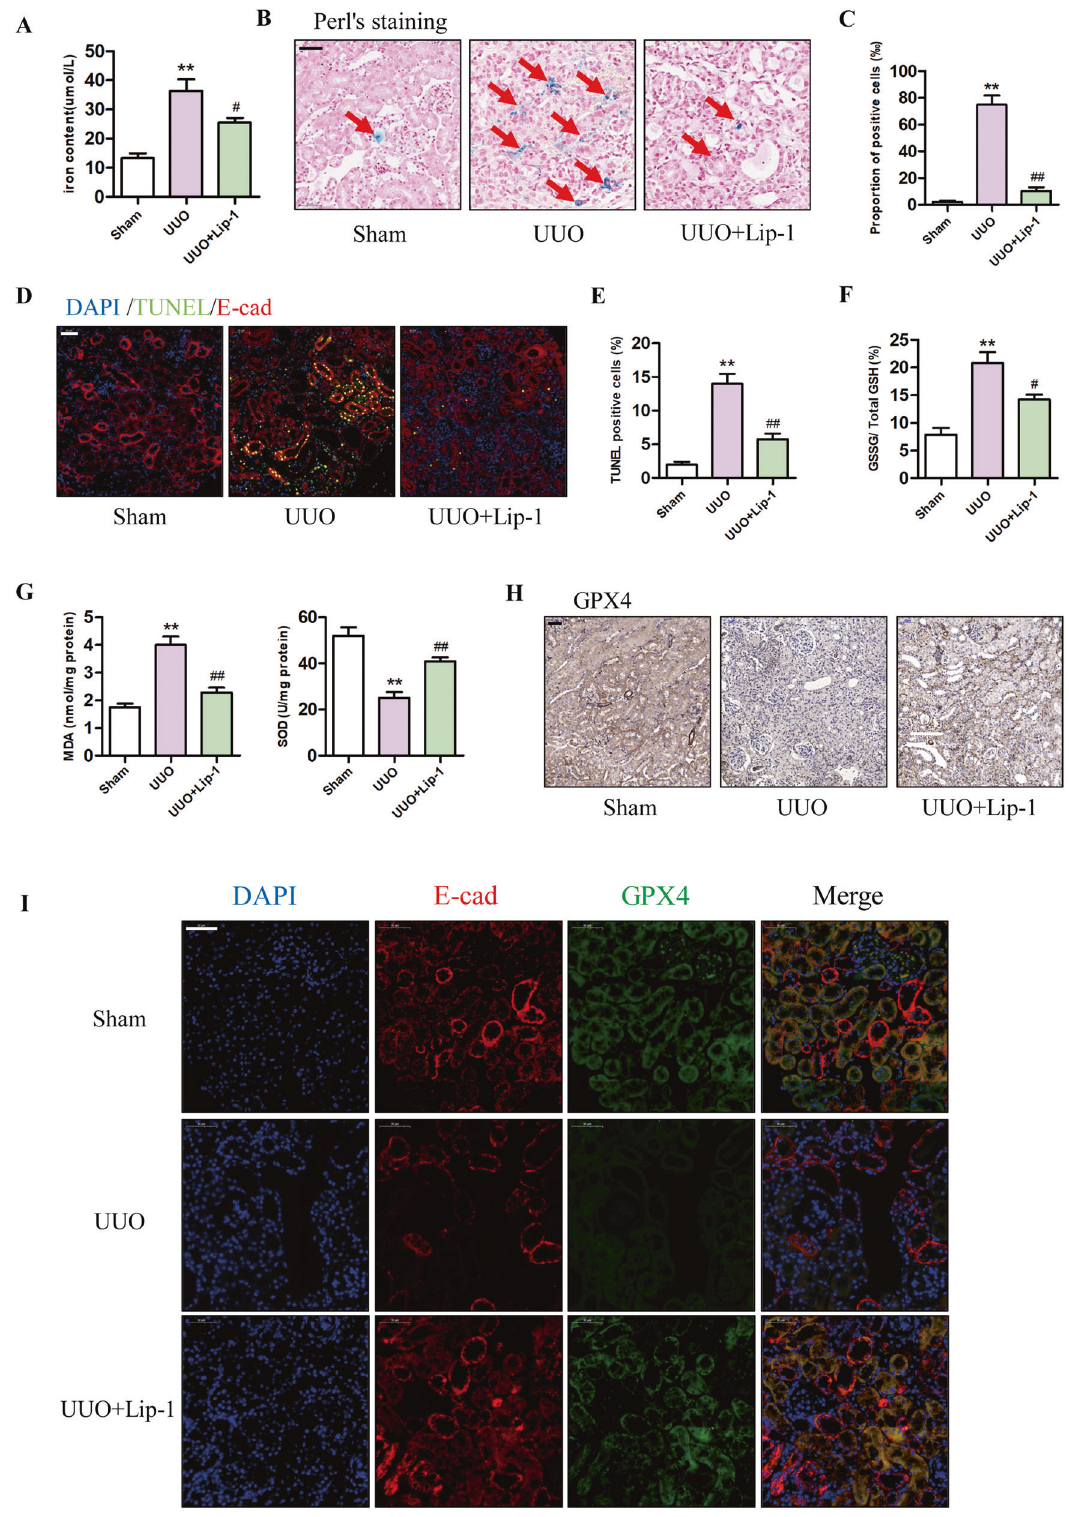
Fig. 1 Effects of Liproxstatin-1 on renal iron deposition, cell death, lipid peroxidation, and GPX4 expression in the UUO model. A Iron concentrations in the kidney tissue lysates ( n = 4, ** P < 0.01 vs Sham group; # P < 0.05 vs UUO group). B Perl ’ s staining of kidney tissues (bar = 50 μ m). C Proportion of Perl ’ s staining positive cells ( n = 4, ** P < 0.01 vs Sham group; ## P < 0.01 vs UUO group). D E-cad and TUNEL co-staining in the kidney tissues, DAPI (blue), E-cad (red), and TUNEL (green) (bar = 50 μ m). e Quanti fi cation of TUNEL-positive cells in the kidney tissues ( n = 4, ** P < 0.01 vs Sham group; ## P < 0.01 vs UUO group). F GSSG/total GSH ratio in kidney tissues ( n = 4, ** P < 0.01 vs Sham group; # P < 0.05 vs UUO group). G MDA and SOD levels in the kidney tissues ( n = 4, ** P < 0.01 vs Sham group; ## P < 0.01 vs UUO group). H Immunohistochemical staining results of GPX4 in kidney tissues (bar = 50 μ m). I Immuno fl uorescent analysis with nuclear stained with DAPI (blue), E-cad (red), and GPX4 (green) in kidney tissue sections (bar = 50 μ m). The data are presented as the mean ±